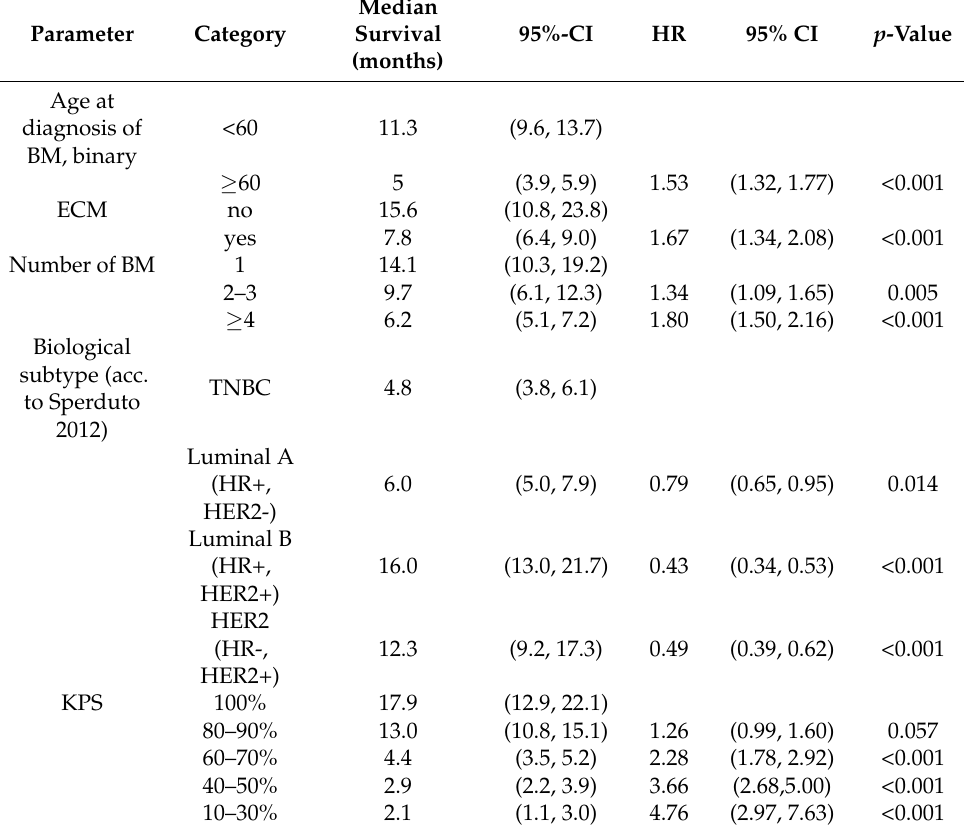
Table 3. Median overall survival after the diagnosis of brain metastases (BM) (univariate